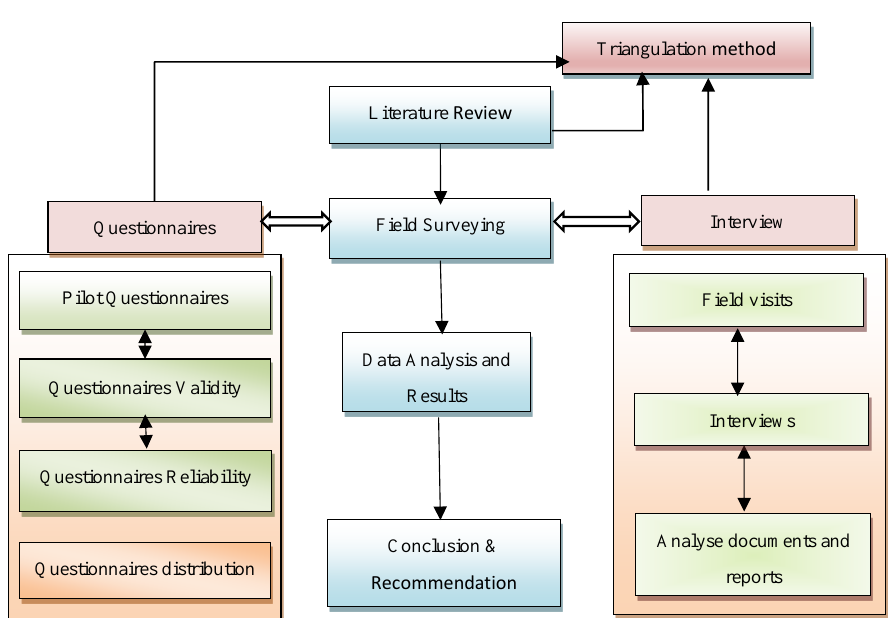
Figure 3. Research